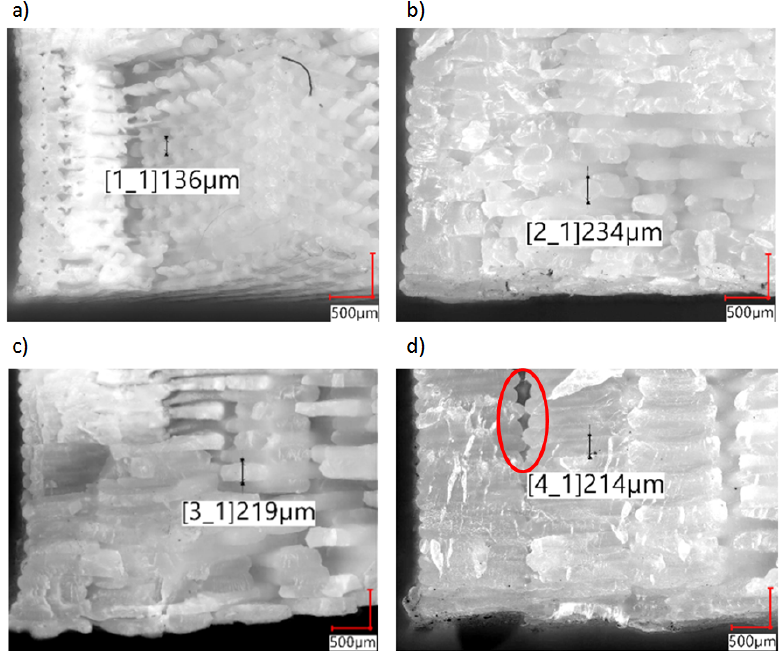
Figure 8. Microscope images of fracture of tested specimens with example layer thickness measured: ( a ) 0.2 mm diameter nozzle, ( b ) 0.4 mm diameter nozzle, ( c ) 0.8 mm diameter nozzle, ( d ) 1.2 mm diameter nozzle.